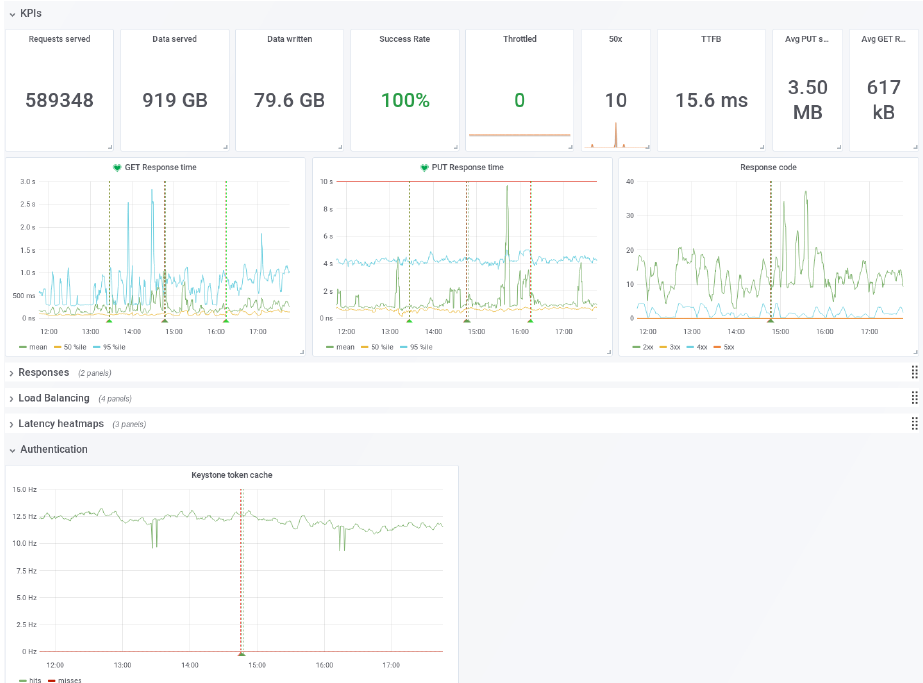
Figure 4. S3 dashboard, combining Traefik and RadosGW